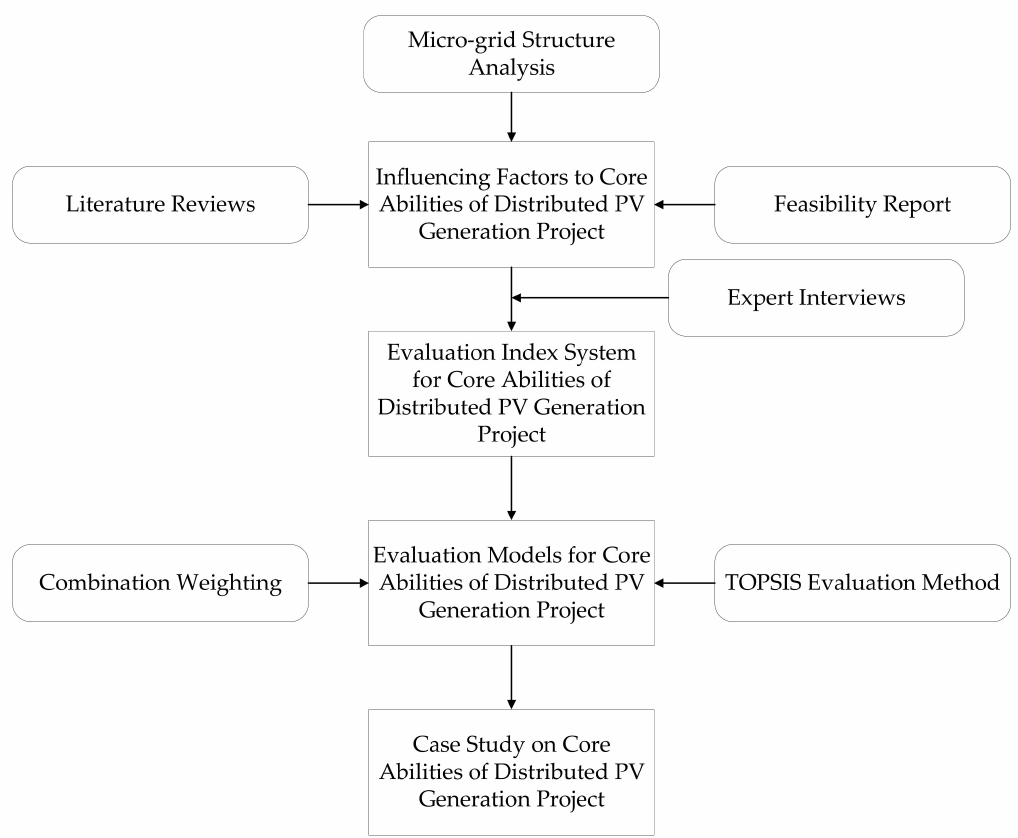
Figure 1. The research process for the core abilities of distributed PV-generation